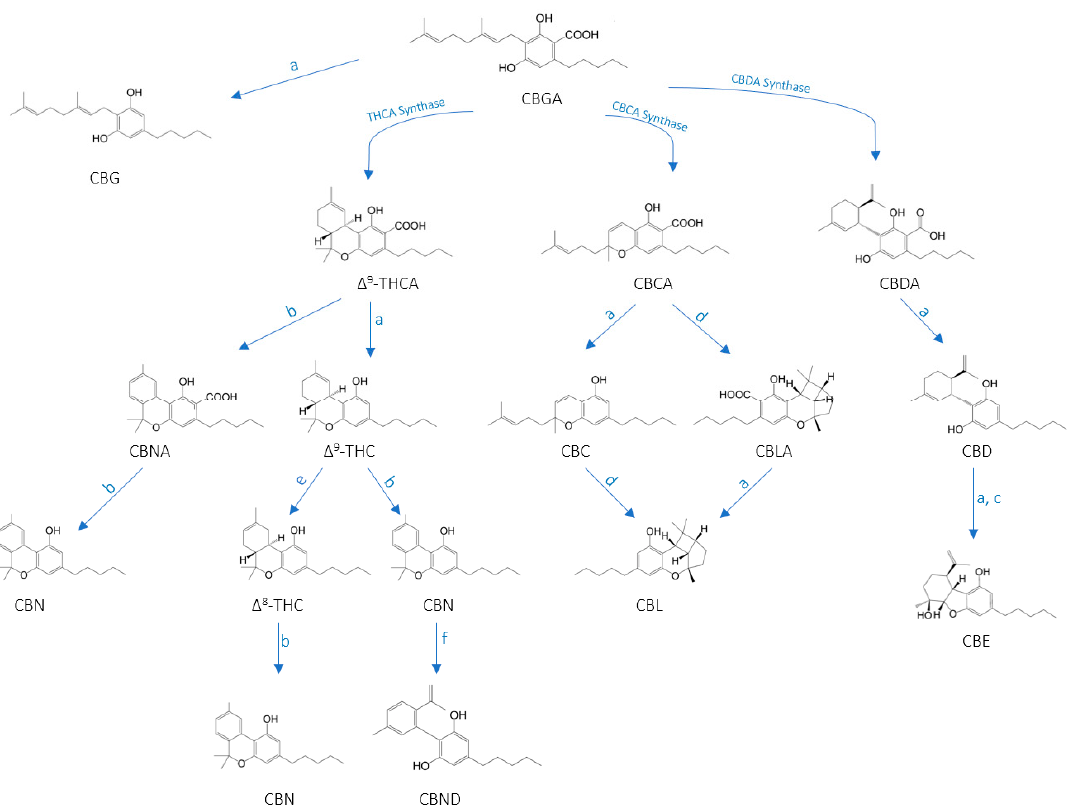
Figure 1. Chemical structures and biosynthesis of the major cannabinoids present in Cannabis sativa L : a = heating, b = oxidation, c = photo-oxidation, d = photo-irradiation, e = isomerization, f = photochemical conversion [21,39] .